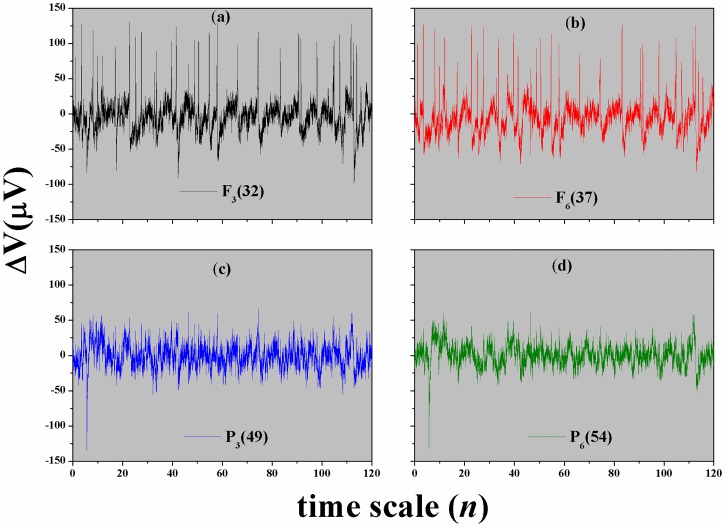
(Color on-line) Original time series of the EEG signal.Channels (a) F332 and (b) F637 represent the frontal region of the brain, and (c) P349 and (d) P654 represent the parietal region. These time series correspond to the subject S020 at the Task 1 (open and close left or right fist).